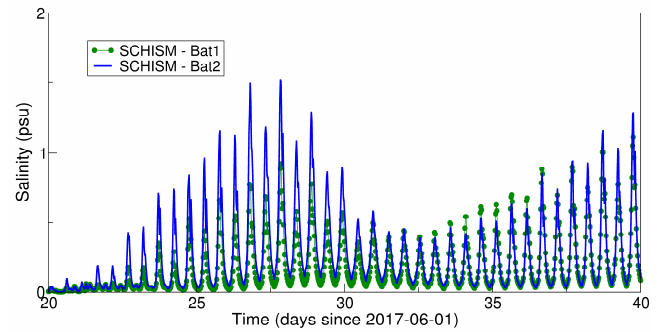
Figure 7. Influence of the upstream bathymetry in the salinity results at the Conchoso station: definition of the bathymetry upstream of Vila Franca de Xira using rectangular cross-sections with varying width and depth (Bat1) and a method derived from [40] (Bat2, see Appendix A for